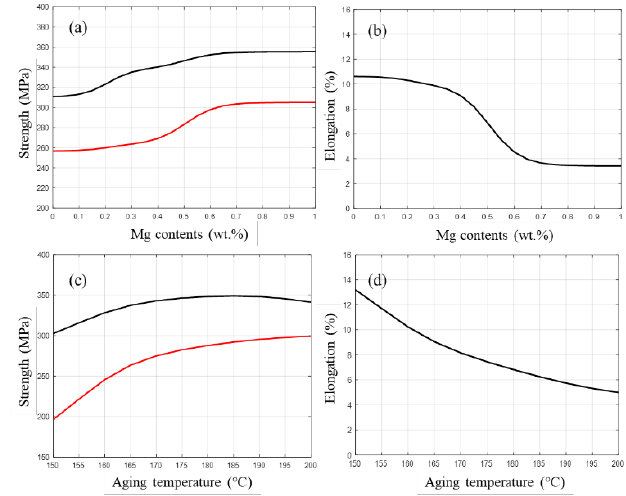
Figure 6. Predicted mechanical properties with ( a , b ) Mg content and ( c , d ) aging temperature.